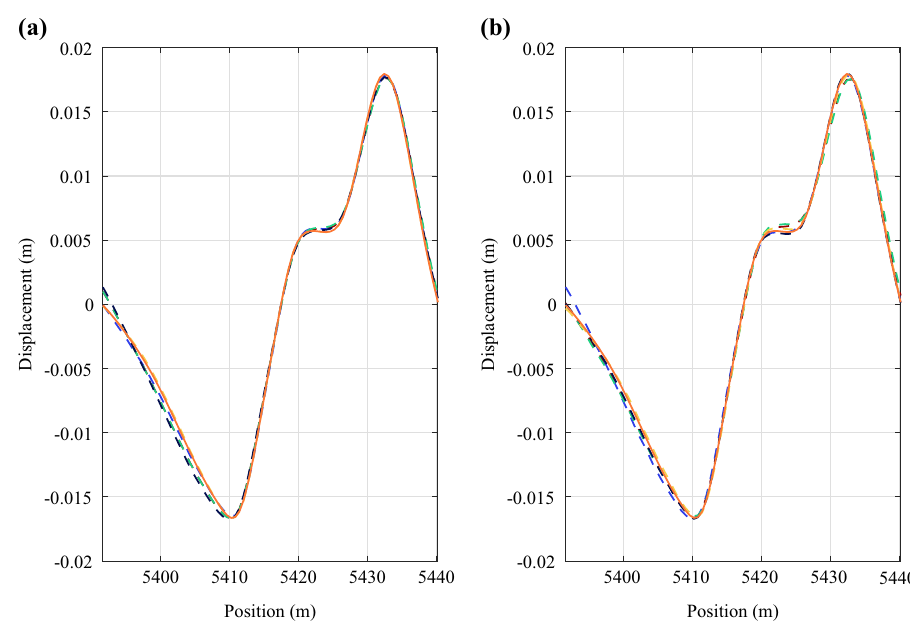
Fig. 21 Wheelset displacement at the large dip at 5400–5440 m, with the same color scheme as in Figs. 18a and b and 20: a a zoomed-in ver- sion of Fig. 18c and b a zoomed-in version of Fig. 19c. Both figures show that the noise causes minimal differences in the dynamics of the wheelset